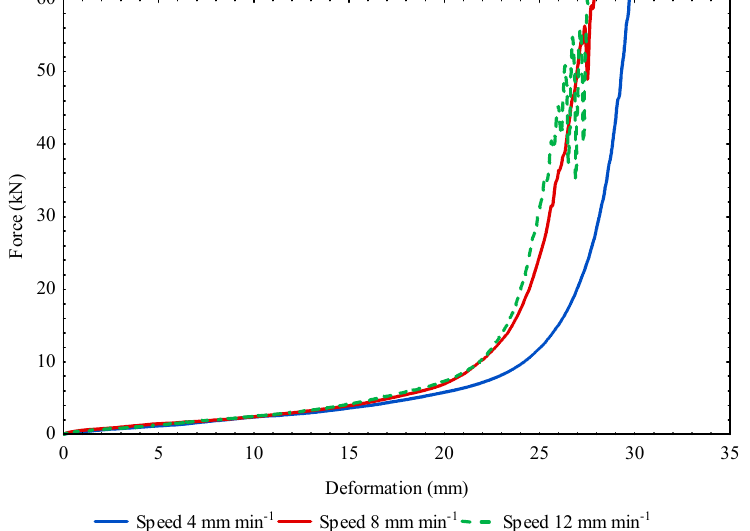
Figure 2. Force–deformation curves of bulk hazelnut kernels for different speeds.